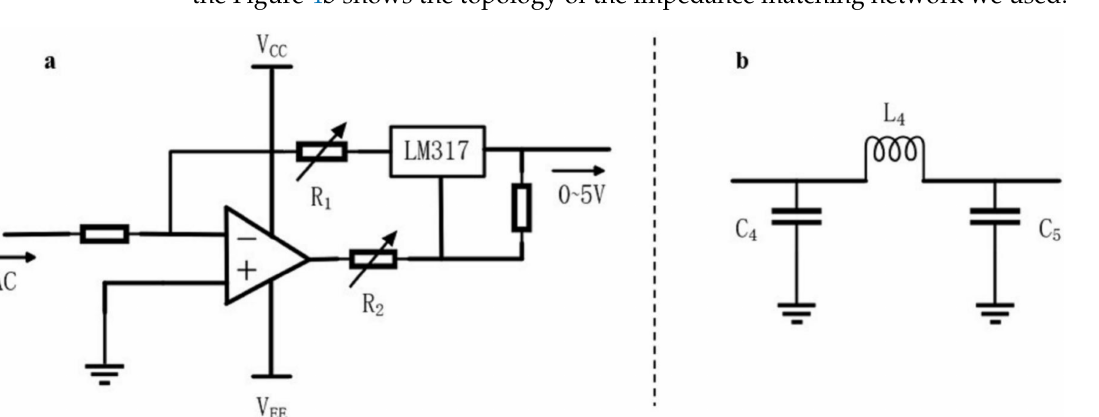
Figure 4. ( a ) The control circuit diagram of DAC output. The input is the DAC voltage of 0–3.3 V. The output voltage is 0–5 V; ( b ) The π type impedance matching